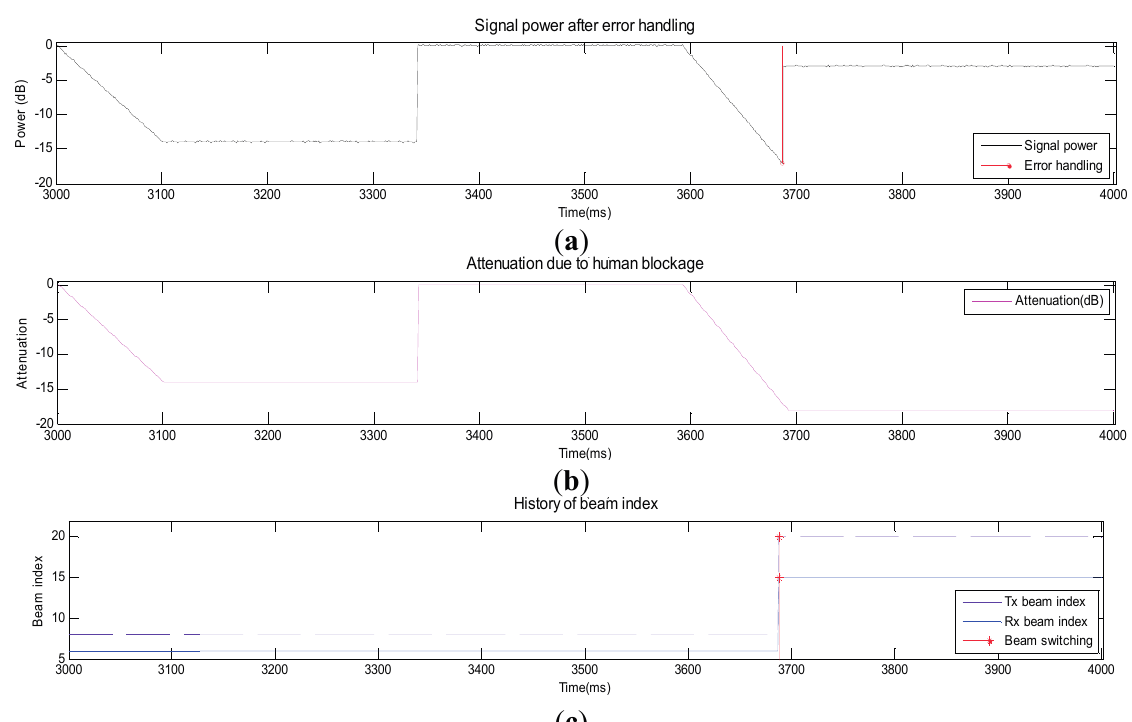
Figure 8. Performance of the proposed beam-tracking technique in Scenario